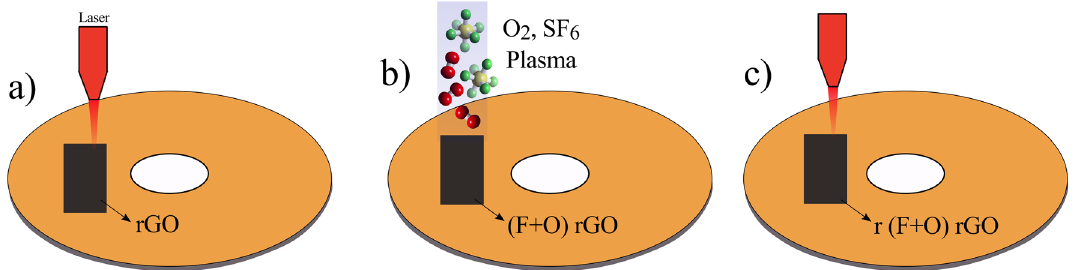
Figure 2. ( a ) Reduction of GO into rGO by the lightscribe method. ( b ) Plasma treatment of prepared rGO with SF 6 and O 2 gases. ( c ) Lightscribe reducing of the (F + O)rGO